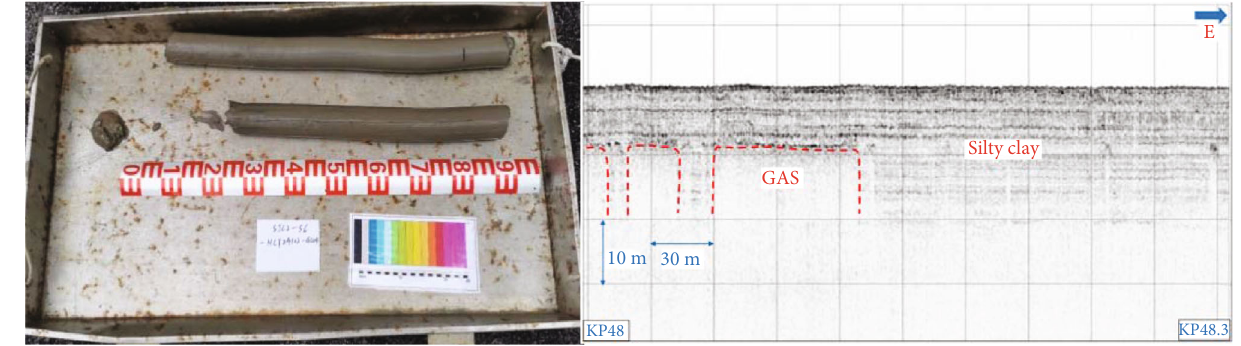
Figure 10: Typical sediment photos and shallow stratigraphic pro fi le images of the nearshore section (left is the sediment photo, and right is the shallow stratigraphic pro fi le